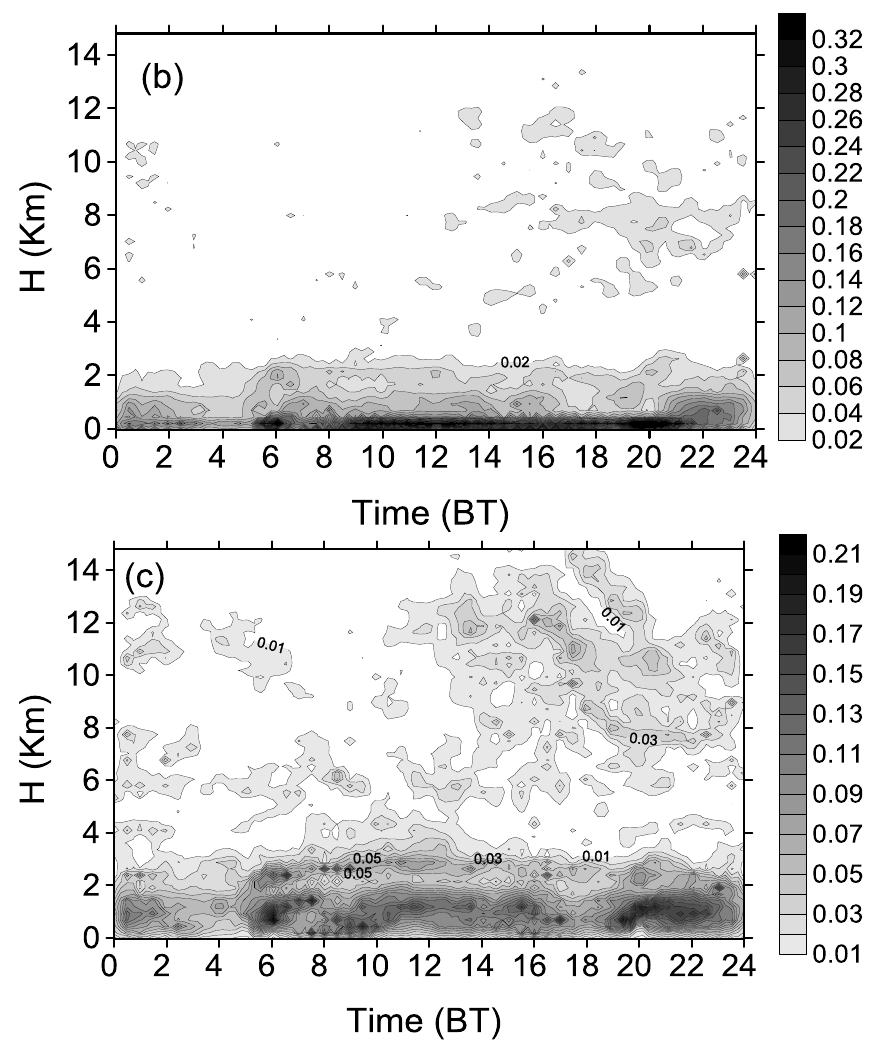
Figure 16. Diurnal variations of occurrence frequency of cloud-base heights from ( a ) CEIL observation; and ( b ) the merged data; and ( c ) cloud-top heights from the merged data.